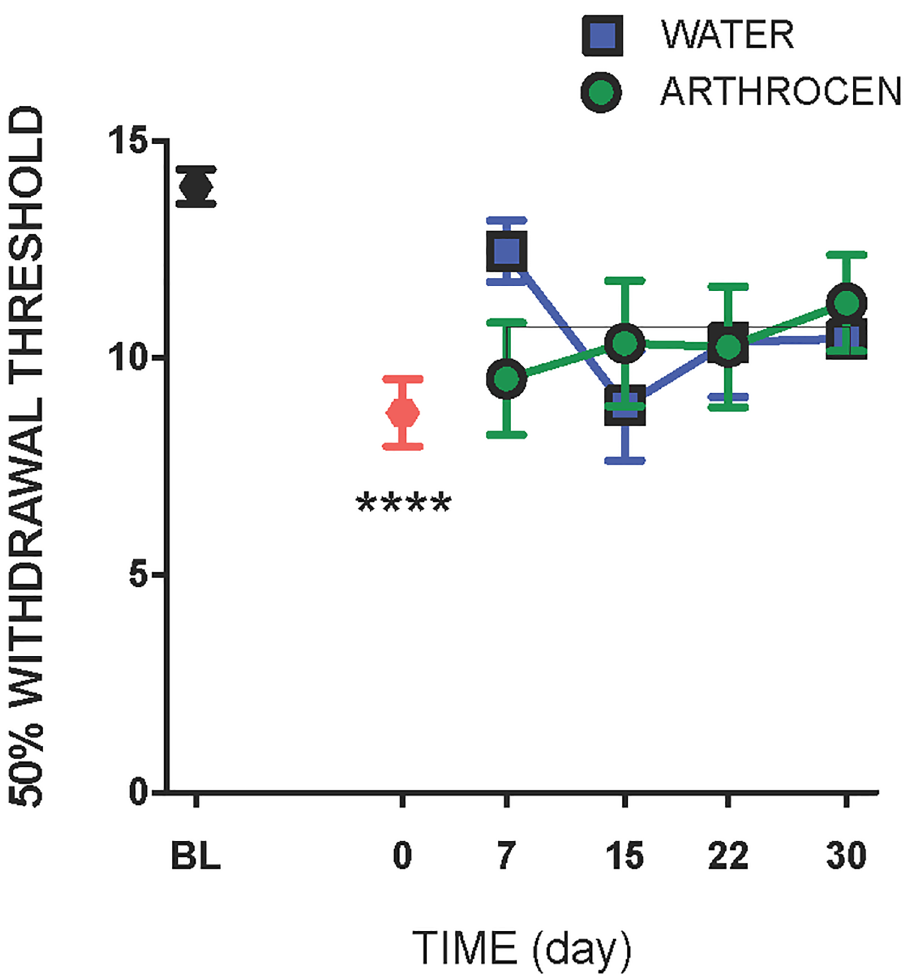
Fig 3. Effect of Arthrocen treatment on secondary allodynia in OA rats. Assessment of referred pain by von Frey hair algesiometry demonstrated that Arthrocen had no effect on hindpaw tactile sensitivity. Data shown as means ± S.